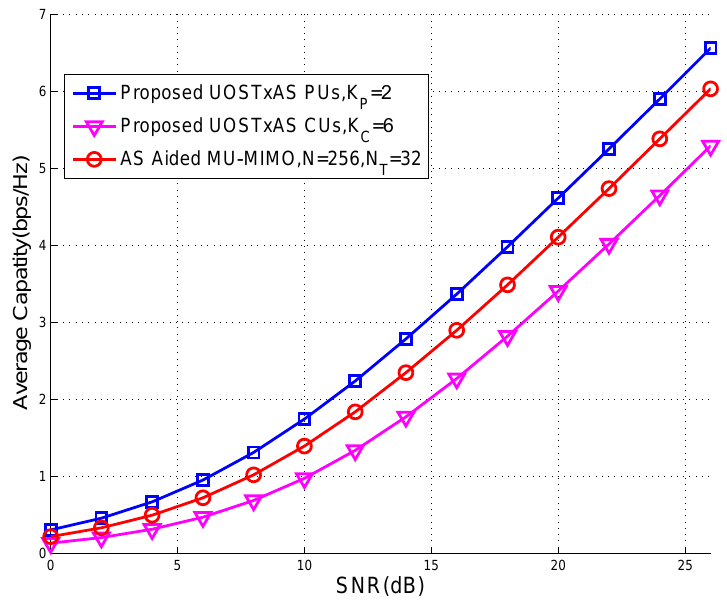
Figure 7. Achievable capacity performance comparison of proposed UOSTxAS in case of { K P = 2, K C = 6 } and AS aided MU-MIMO systems associated with K = 8 active users, N = 256 TAs, N T = 32 transmit RF